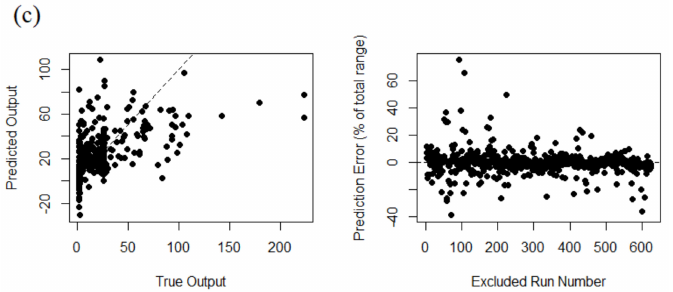
Figure 8. Leave-one-out cross-validation analysis results for time steps 7, 70, and 140 ( a – c